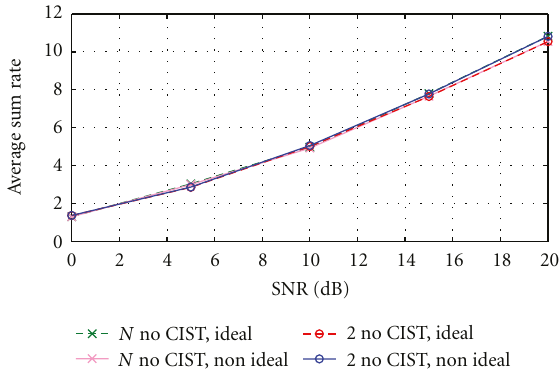
Figure 10: Bit error-rate for 4-QAM symbols, as a function of the SNR, for N = 10 base stationswith collaborating CFR pairs, and N = 2 isolated BSs. α = 0 . 1.